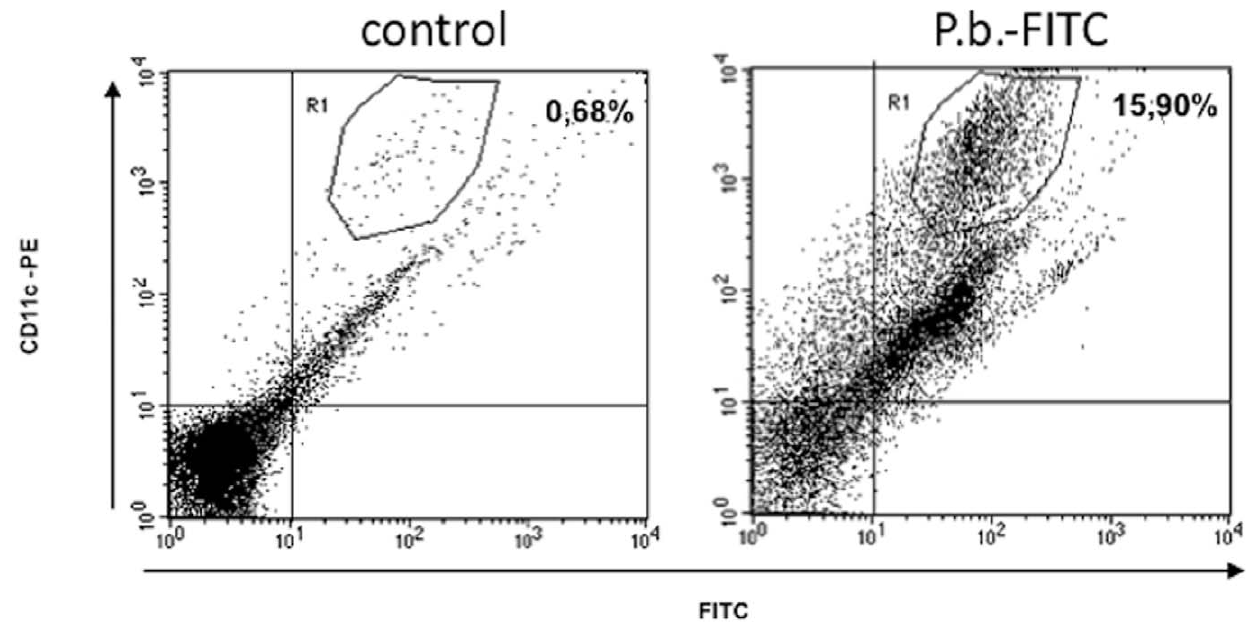
Figure 4. DC transport yeast form of Pb to draining lymph nodes. Yeast form of Pb were labeling with FITC as described in the M&M. After labeling, 1 6 10 6 Pb were injected intratracheally. After 12 h, the lymph node cells were removed and analyzed by cytometry. Animals injected with FITC only were used as controls. The Figure is representative of 3 different experiments. The number represent the percentage of positive cells.